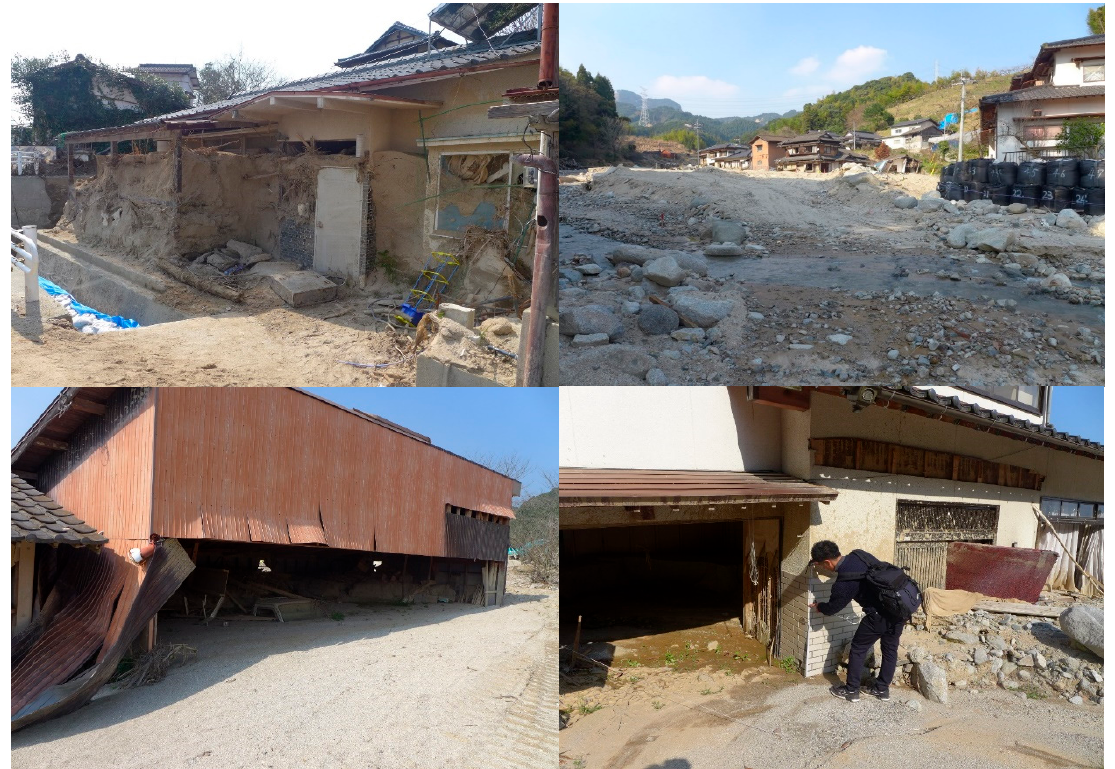
Figure 3. Situations of the flood disaster in the Shirakitani River Basin (as of March 25, 2018).